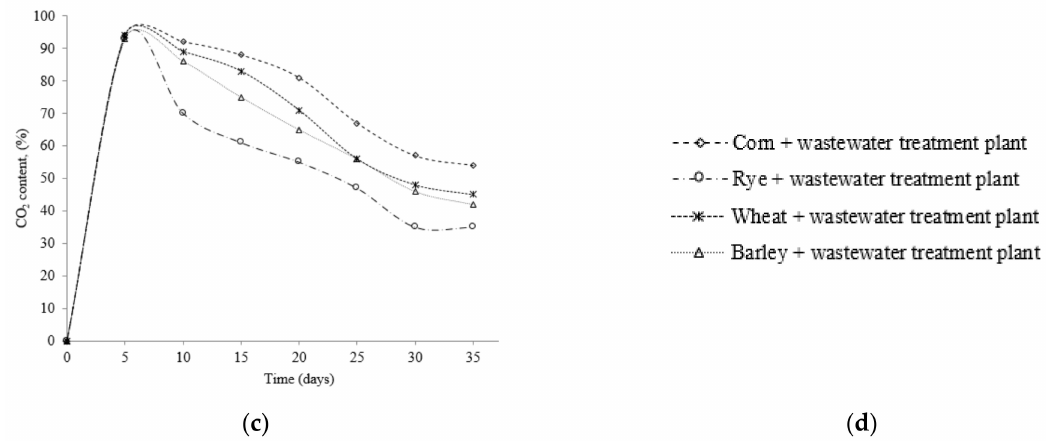
Figure 4. Substrate evolution during biogas production tests in small-scale reactors: ( a ) pH evolution; ( b ) Methane production; ( c ) Carbon dioxide production; and ( d ) graphics legend.